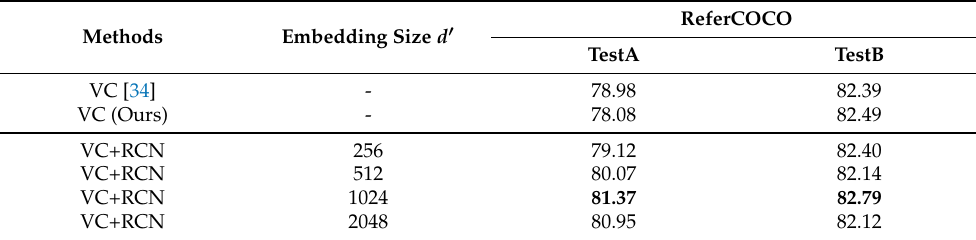
Table 3. Performances on ReferCOCO with different embedding sizes (from 256 to 2048) of RCN. The bold type indicates the state-ot-the-art